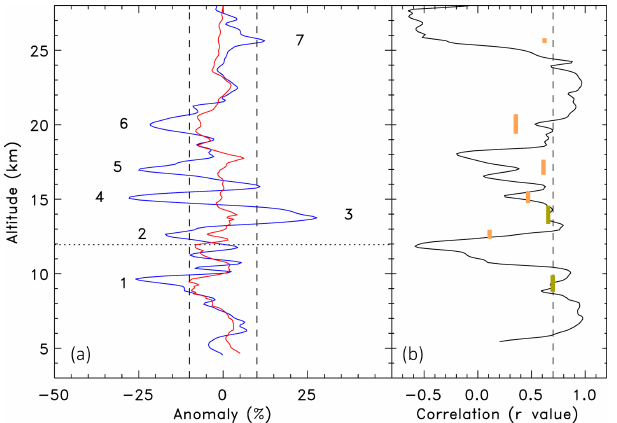
Figure 4. Two simulated ozone profiles with randomly placed lami- nae applied to a tropical basic state (a, b) , and to a midlatitude basic state (c, d) . In each case, panels (a) and (c) show the simulated ozone (solid) and the derived basic state (dashed), while panels (b) and (d) show the actual anomaly profile for each simulation (solid), along with the derived anomaly profile (dashed). Horizontal dotted lines in panels (a) and (c) denote the tropopause level, and vertical dotted lines in panels (b) and (d) denote the 10% anomaly threshold used for detecting ozone